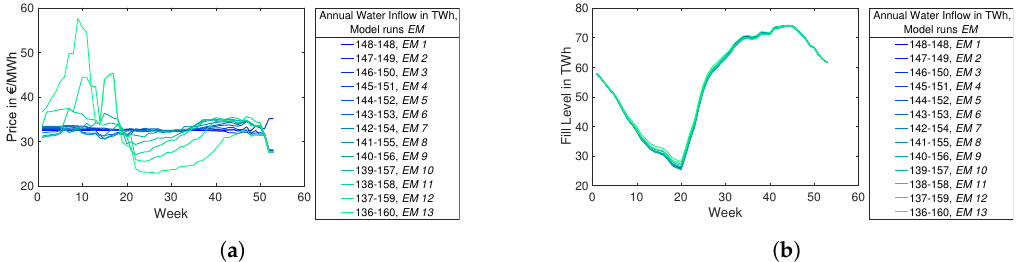
Figure 8. Impact of uncertainty on electricity prices: Realizing water inflow is the expectation value of the inflow scenarios. ( a ) impact of uncertainty on electricity prices; ( b ) impact of uncertainty on storage fill levels.